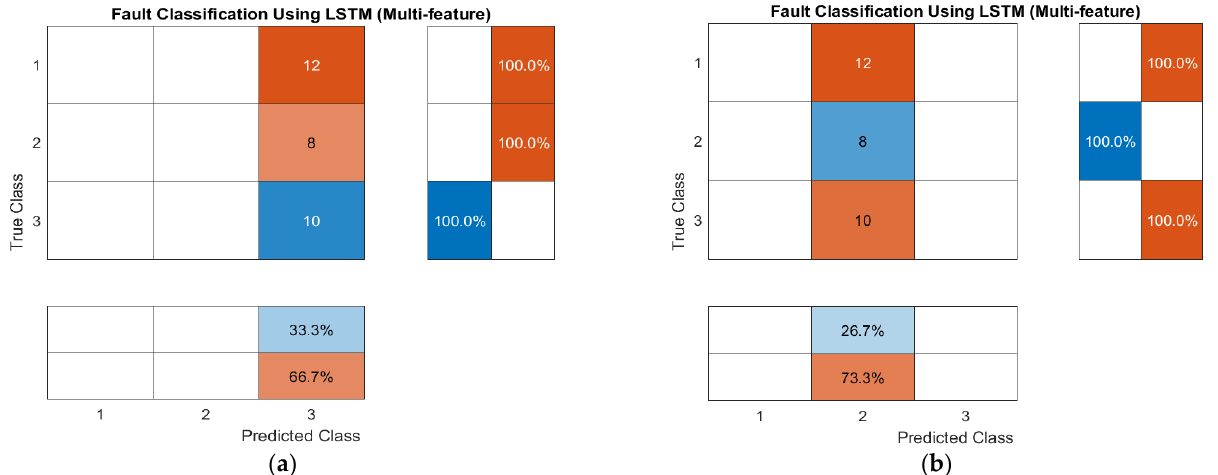
Figure 10. Confusion Matrix for LSTM Model: ( a ) Case 1; ( b ) Case 2. Table 10. LSTM Multivariate Performance.